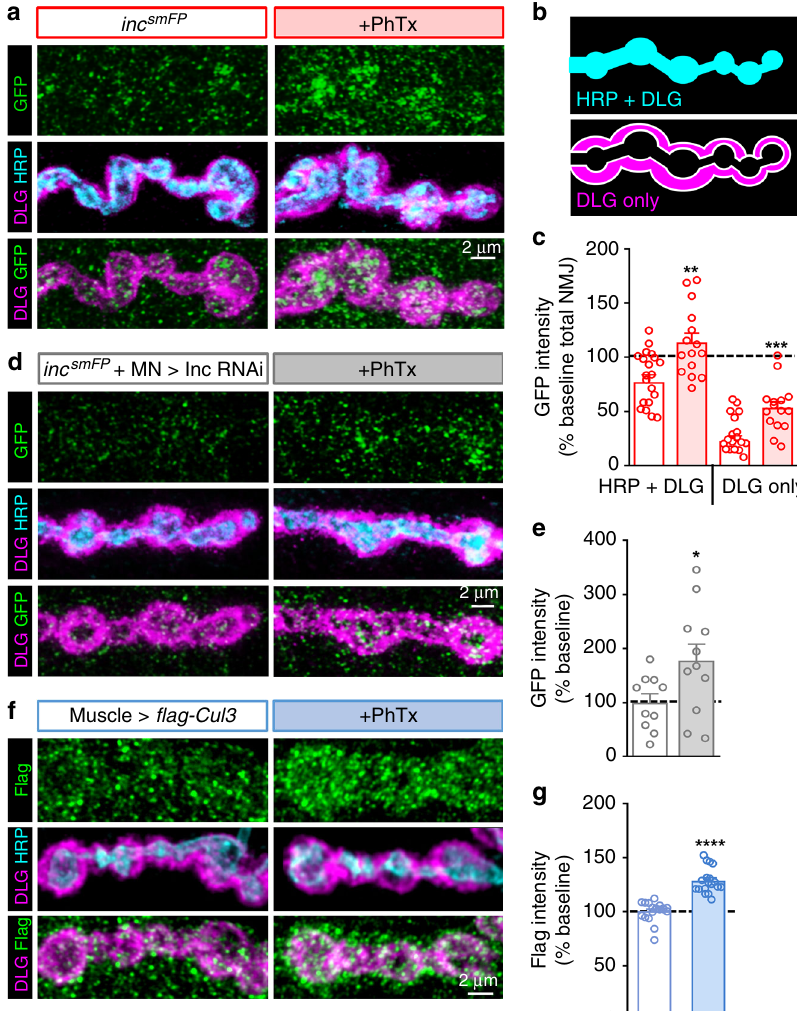
Fig. 4 Inc and Cul3 levels are rapidly enhanced at postsynaptic densities following glutamate receptor perturbation. a Representative NMJ image of endogenously tagged Inc smFP before and after PhTx application. NMJs are immunostained with anti-GFP (Inc smFP ), the presynaptic membrane marker HRP, and the postsynaptic density marker DLG. Note the increase in Inc smFP levels at NMJs (labeled by HRP and DLG). b Schematic illustrating the HRP + DLG signal (where Inc smFP overlaps in both pre- and postsynaptic areas) and the DLG only component (where only postsynaptic Inc smFP overlaps with DLG). c Quanti fi cation of Inc smFP intensity at speci fi ed areas following PhTx application relative to baseline ( – PhTx) ( – PhTx: inc smFP , n = 21; + PhTx: inc smFP